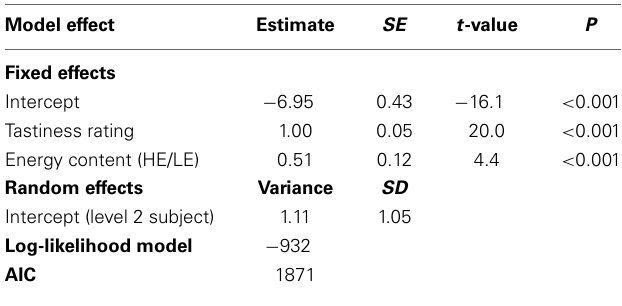
Table 1 | Multi-level logistic regression results: energy content and self-reported tastiness predict